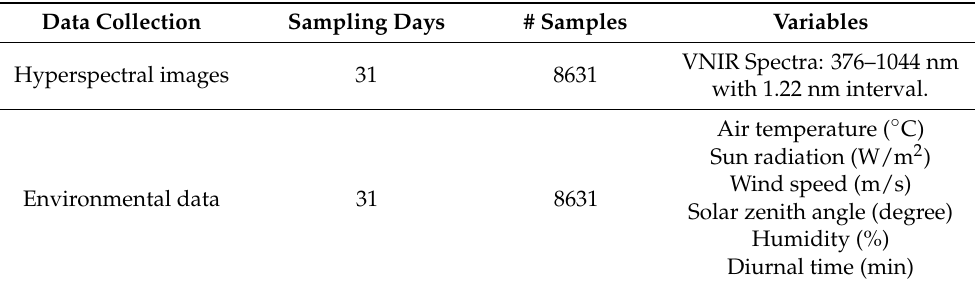
Table 2. Hyperspectral images and environmental data